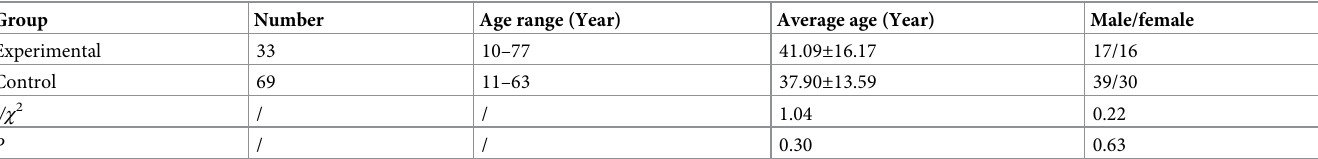
Table 1. Data of experimental group and control group were